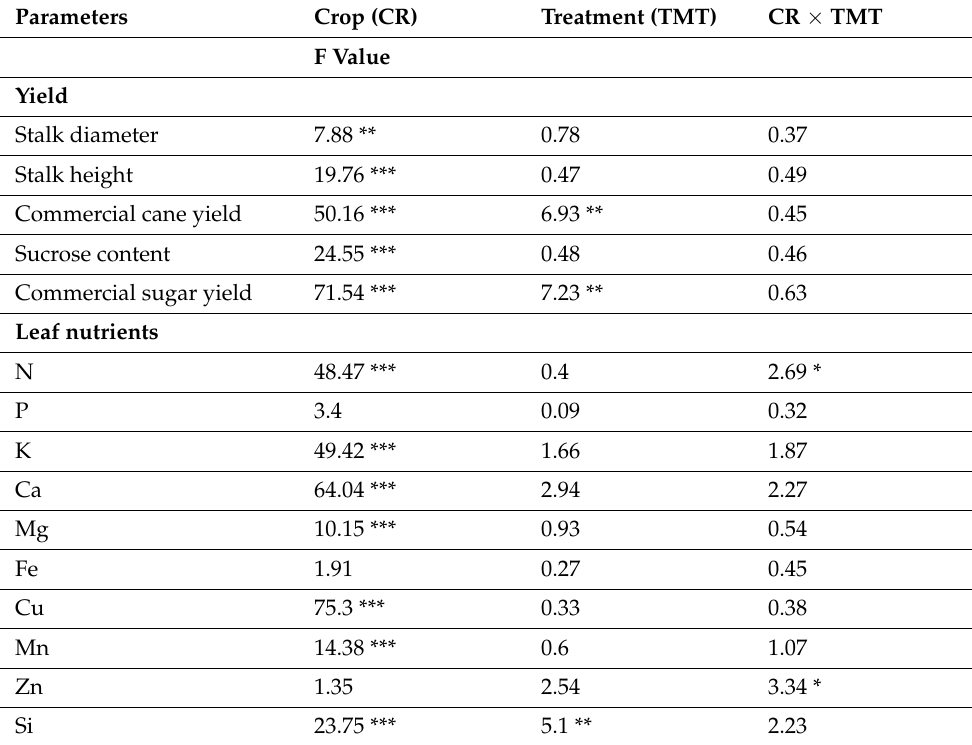
Table 3. Analysis of variance F ratios and level significance for yield parameters and leaf nutrients for crop, treatment, and interaction effects.